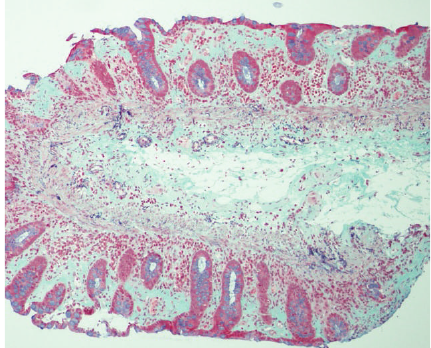
Figure 4: Histological findings of the biopsy specimen revealed the thickened collagen band in the subepithelial layer (Masson trichrome × 100).